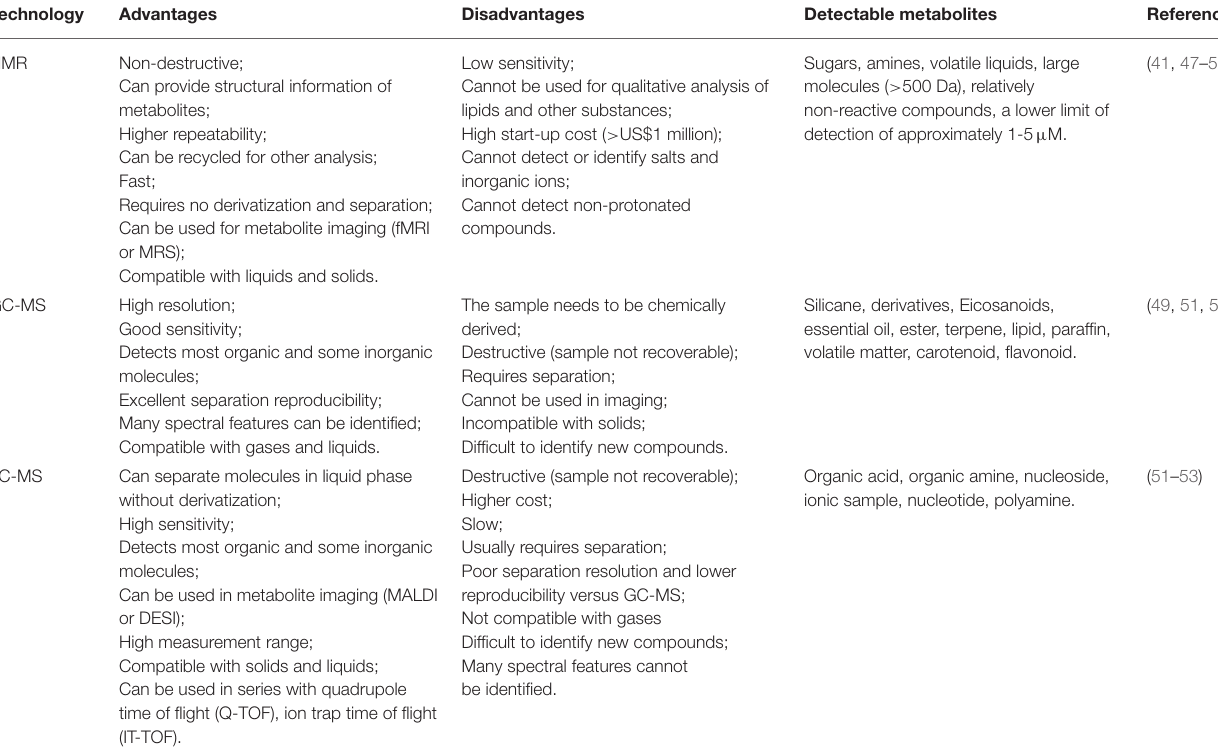
TABLE 1 | Comparison of different